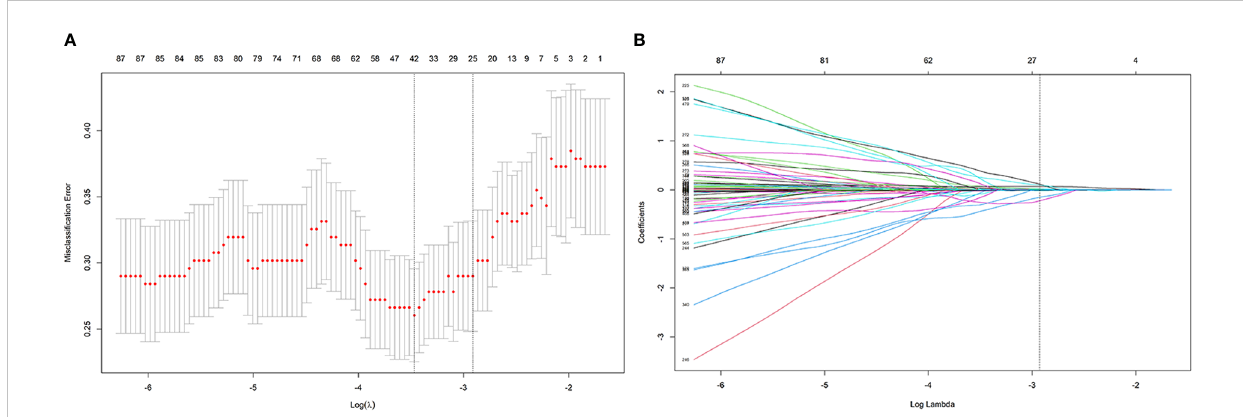
FIGURE 3 The process of feature selection using the LASSO algorithm. (A) Selection of the tuning parameter l in the LASSO classi fifi er via 10-fold cross- validation based on minimum criteria. (B) LASSO coef fi cient pro fi les of the 24 radiomics features.